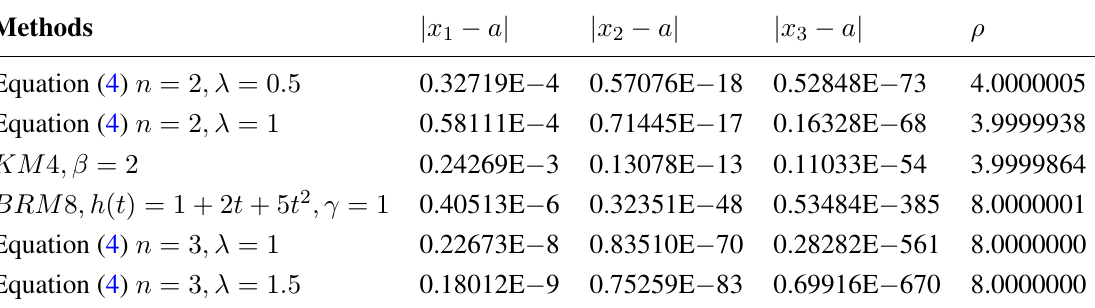
( x ) by the methods without memory. 1